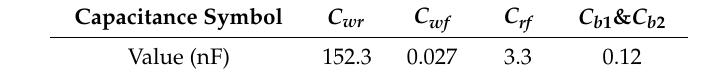
Table 1. Stray capacitances for a 1.5 MW